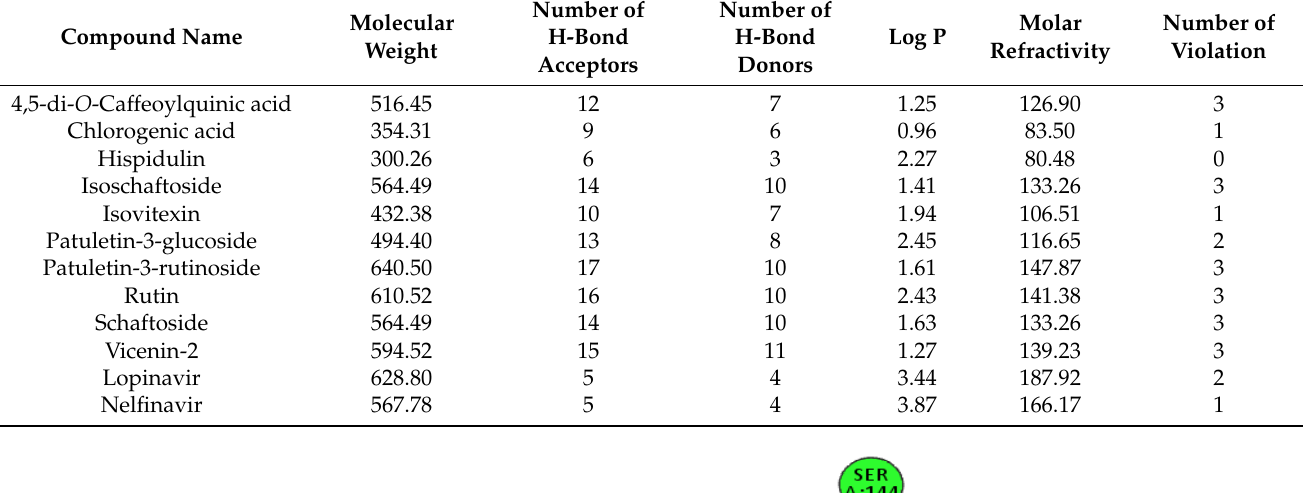
Figure 3. 2D interactions of rutin with Mpro.